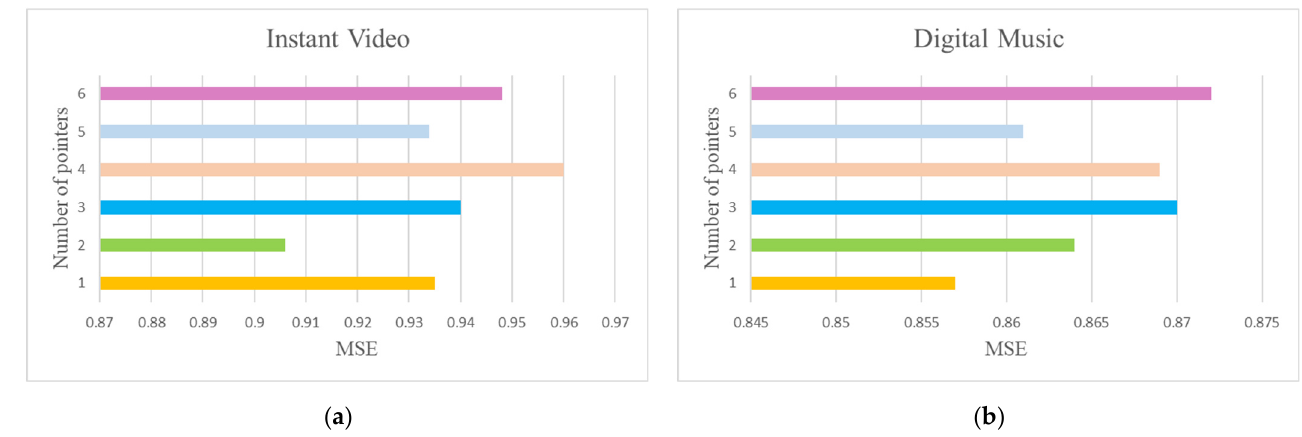
Figure 4. ( a ) Effect of number of pointers on the performance of MPCAR model (Instant Video); ( b ) Effect of number of pointers on the performance of MPCAR model (Digital Music).